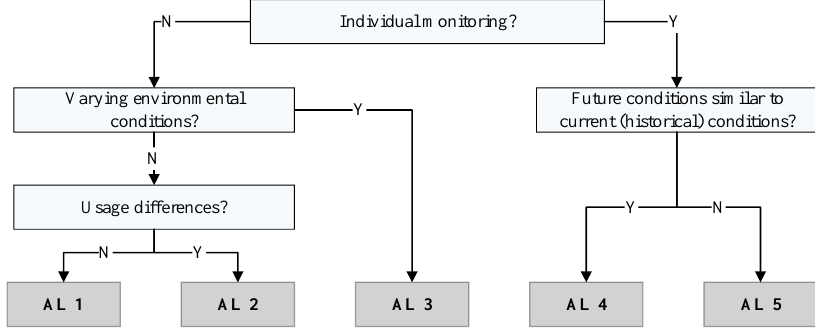
Figure 3. Guideline for the selection of the ambition level. Table 1. Definition of different ambition levels.